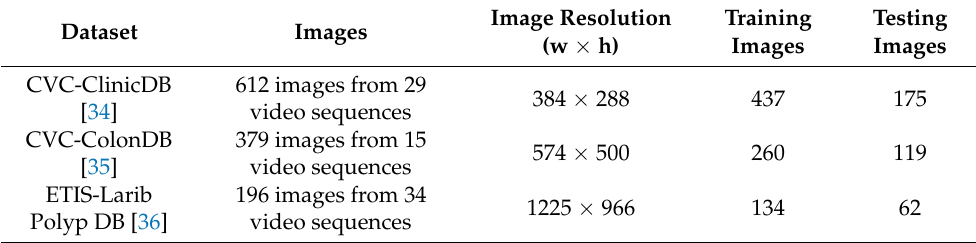
Table 1. Details of the publicly available datasets used for training and testing in this study. Dataset